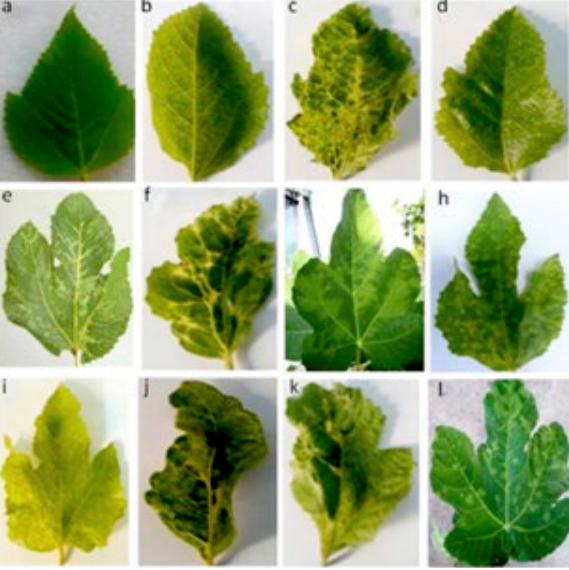
Figure 1. Mosaic-like symptoms on leaves of different dis - eased fig plants observed in orchards from Western Saudi Arabia, showing a range of foliar discoloration and mal- formation. (a) asymptomatic, (b) chlorosis, (c) mosaic, (d) mottling, (e) vein banding, (f) vein feathering, (g) vein clearing, (h) chlorotic blotching, (i) yellowing, (j) leaf de- formation, (k) leaf blistering, (l) chlorotic ring spot.